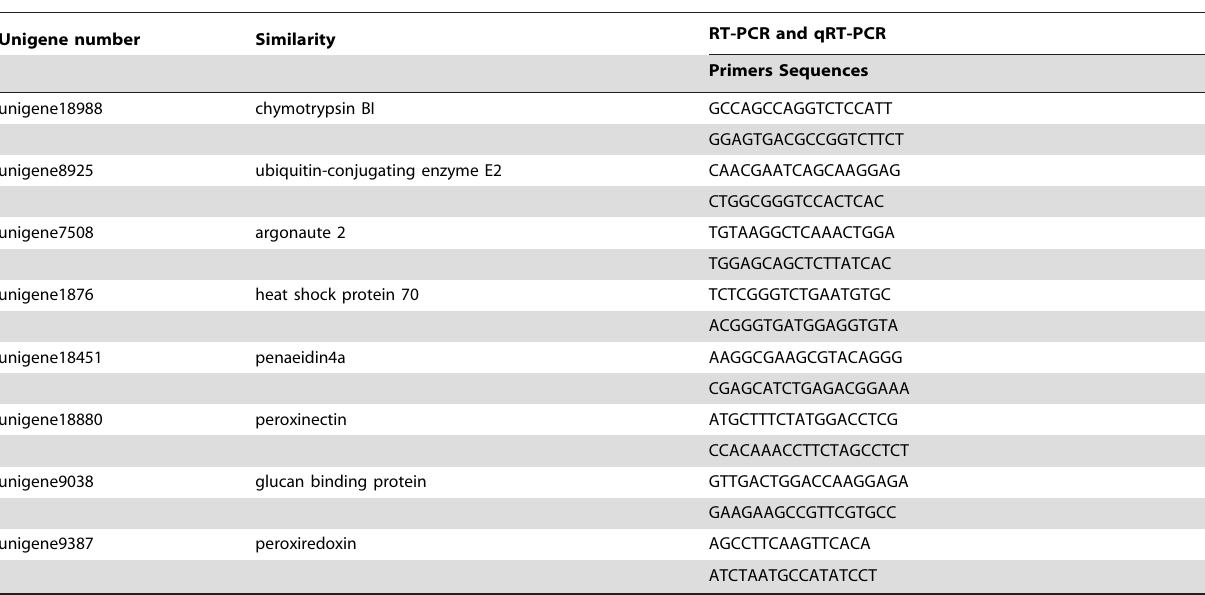
Table 4. Primers used in the validation experiment.